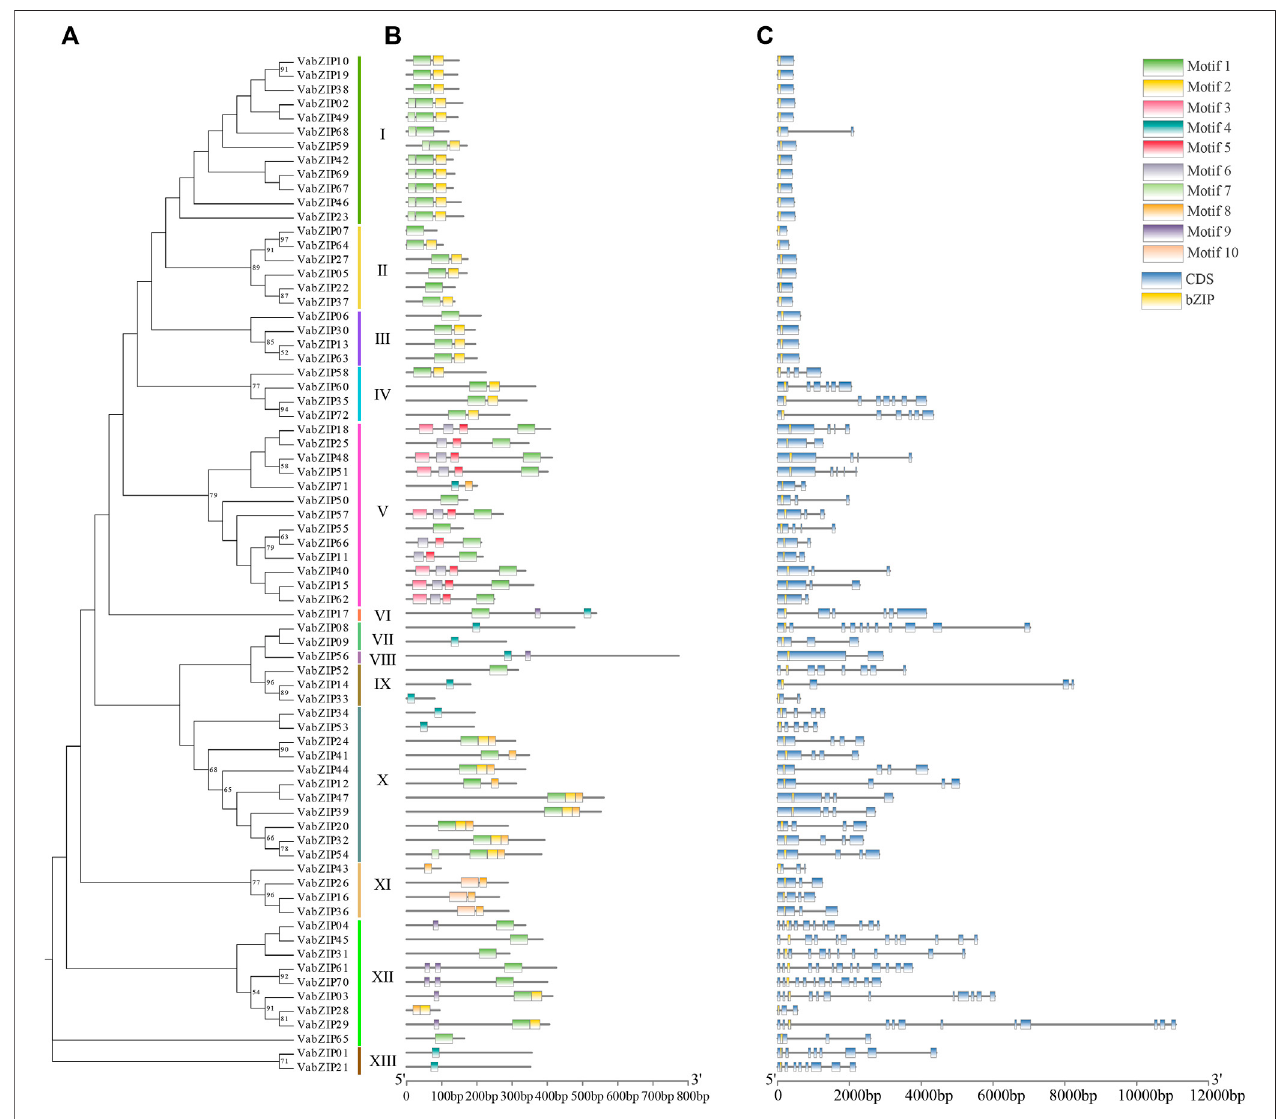
FIGURE3| MotifsandgenestructureofVabZIPs. (A) EvolutionaryanalysisofVabZIPs.Differentcolorsrepresentdifferentsubfamilies (B) ThemotifsofVabZIPs (C) Gene structure of VabZIPs. Blue squares represent CDS while yellow squares represent the bZIP structure.